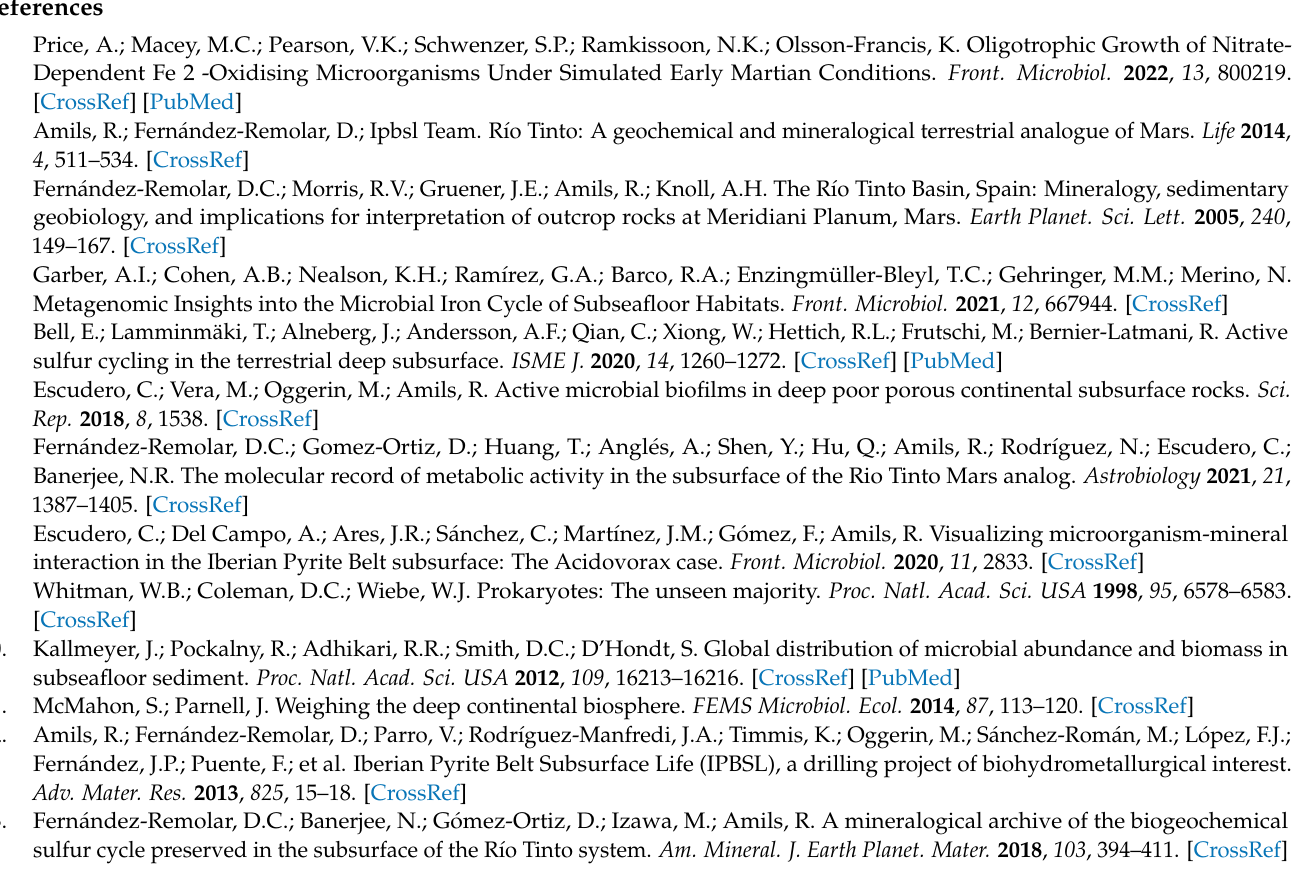
article; Supplementary Table S7: Genes that show 4 copies or more in Shewanella T2.3D-1.1’s genome; Supplementary Table S8: ANI values obtained from comparing Shewanella T2.3D-1.1 to type strain genomes of the Shewanella genus; Supplementary Table S9: dDDH values obtained from comparing Table S10: KEGG mapper information of each gene found in the variant calling analysis from She- wanella putrefaciens CN-32; Supplementary Material S1: CRISPR-Cas Meta tool output when using Shewanella T2.3D-1.1’s chromosome as input; Supplementary Material S2: Aminoacid sequences of all the BtuB proteins from Shewanella T2.3D-1.1 and reference proteins from Escherichia coli and Shigella dysenteriae